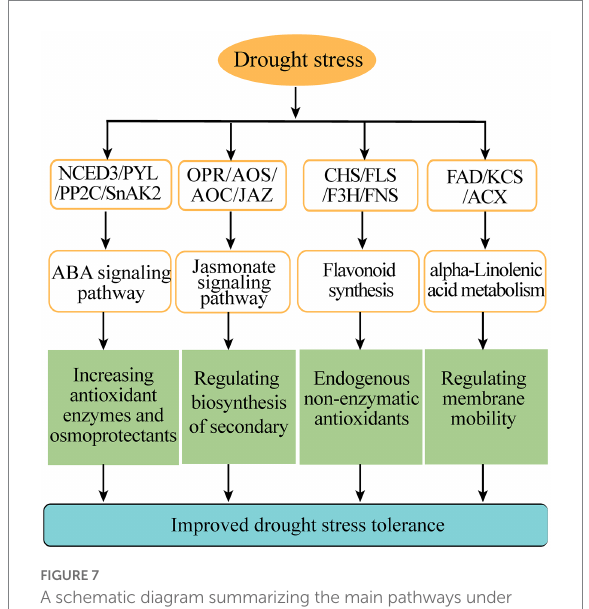
FIGURE 7 A schematic diagram summarizing the main pathways under drought stress. CHS, chalcone synthase; F3H, flavonone 3 β -hydroxylase; FNS, flavones synthase; FLS, flavonol synthase; OPR, 12-oxophytodienoate reductase; AOC, allene oxide cyclase; AOS, allene oxide synthase; JAZ, jasmonate ZIM domain protein; NCED3, 9-cis-epoxycarotenoid dioxygenase; PYL, promoter- pyrabactin resistance; PP2C, type 2C protein phosphatases; SnAK2, SnRK1-activating protein kinase 2; FAD, Fatty acid dehydrogenase; KCS, 3-ketoacyl-CoA synthase; ACX, acyl- coenzyme A